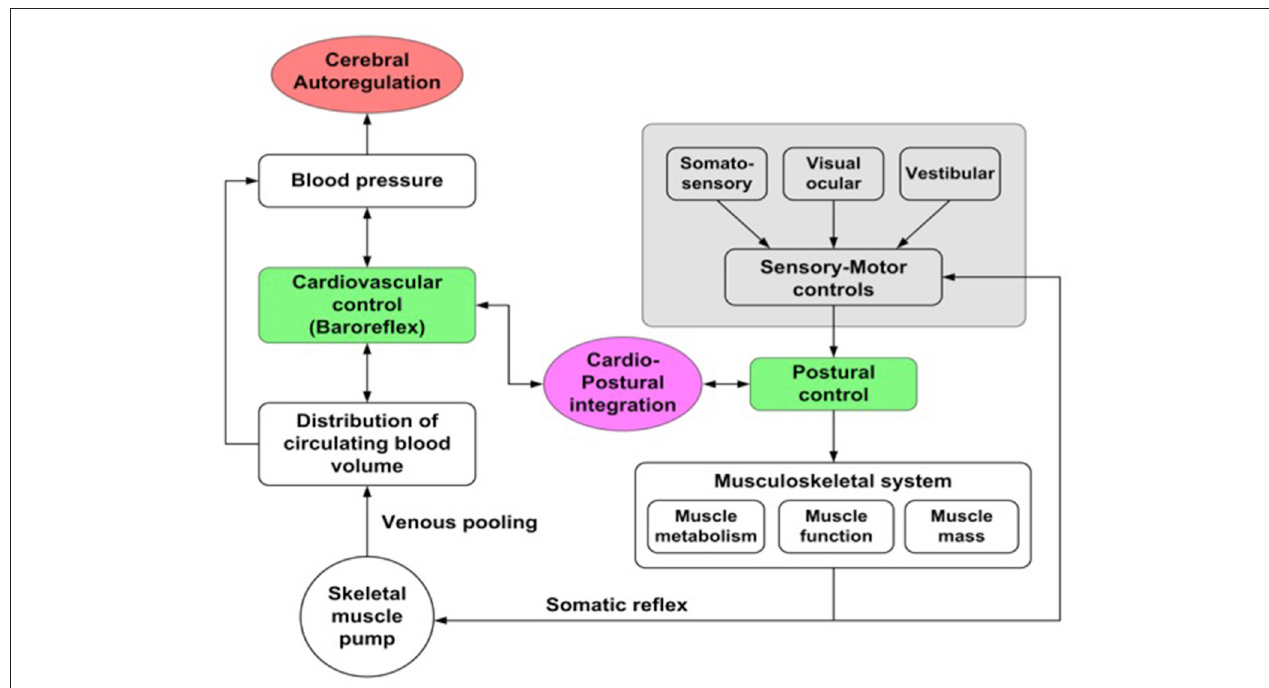
FIGURE 1 | Cardio-postural interactions. Illustration of the cardio-postural components associated with mechanisms that prevent falls: Left —cardiovascular component of the regulation of blood pressure (blood volume, heart rate and vascular resistance); Right —sensory motor input components related to postural control; Center —cardio-postural integration: hypothesized as baroreflex activation of skeletal muscle